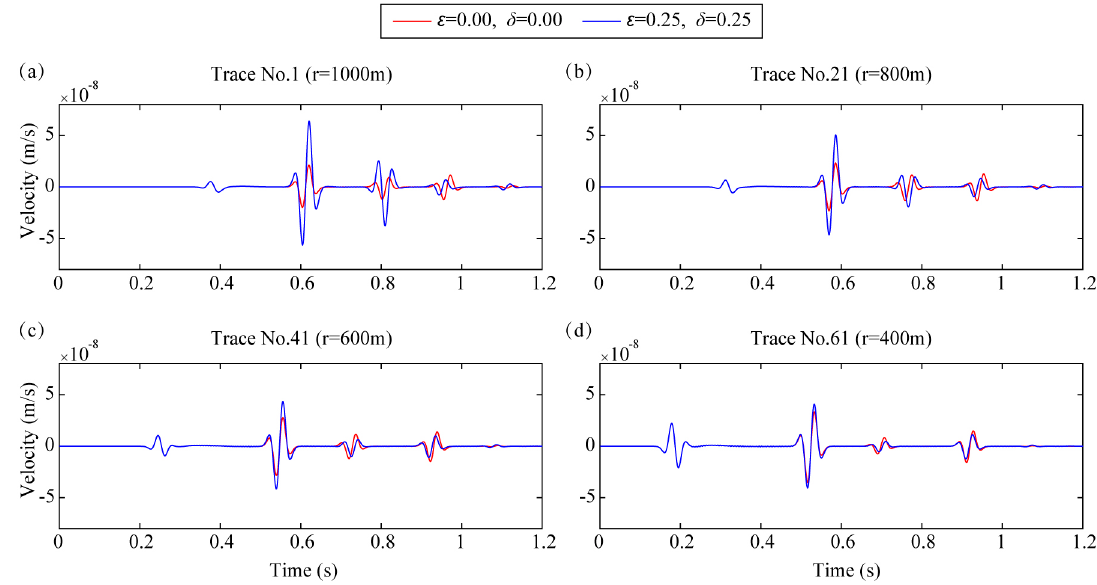
Figure 4. Comparison of Z-component waveforms from model M ED and (with / without anisotropy, VTI). ( a ) / ( b ) / ( c ) / ( d ) are waveforms of geophones No.1 / 21 / 41 / 61 (with epicentral distance 1000 / 800 / 600 / 400 m), respectively. Red indicates seismic waveforms of M 0 (without anisotropy); blue indicates seismic waveforms from M ED (with anisotropy).